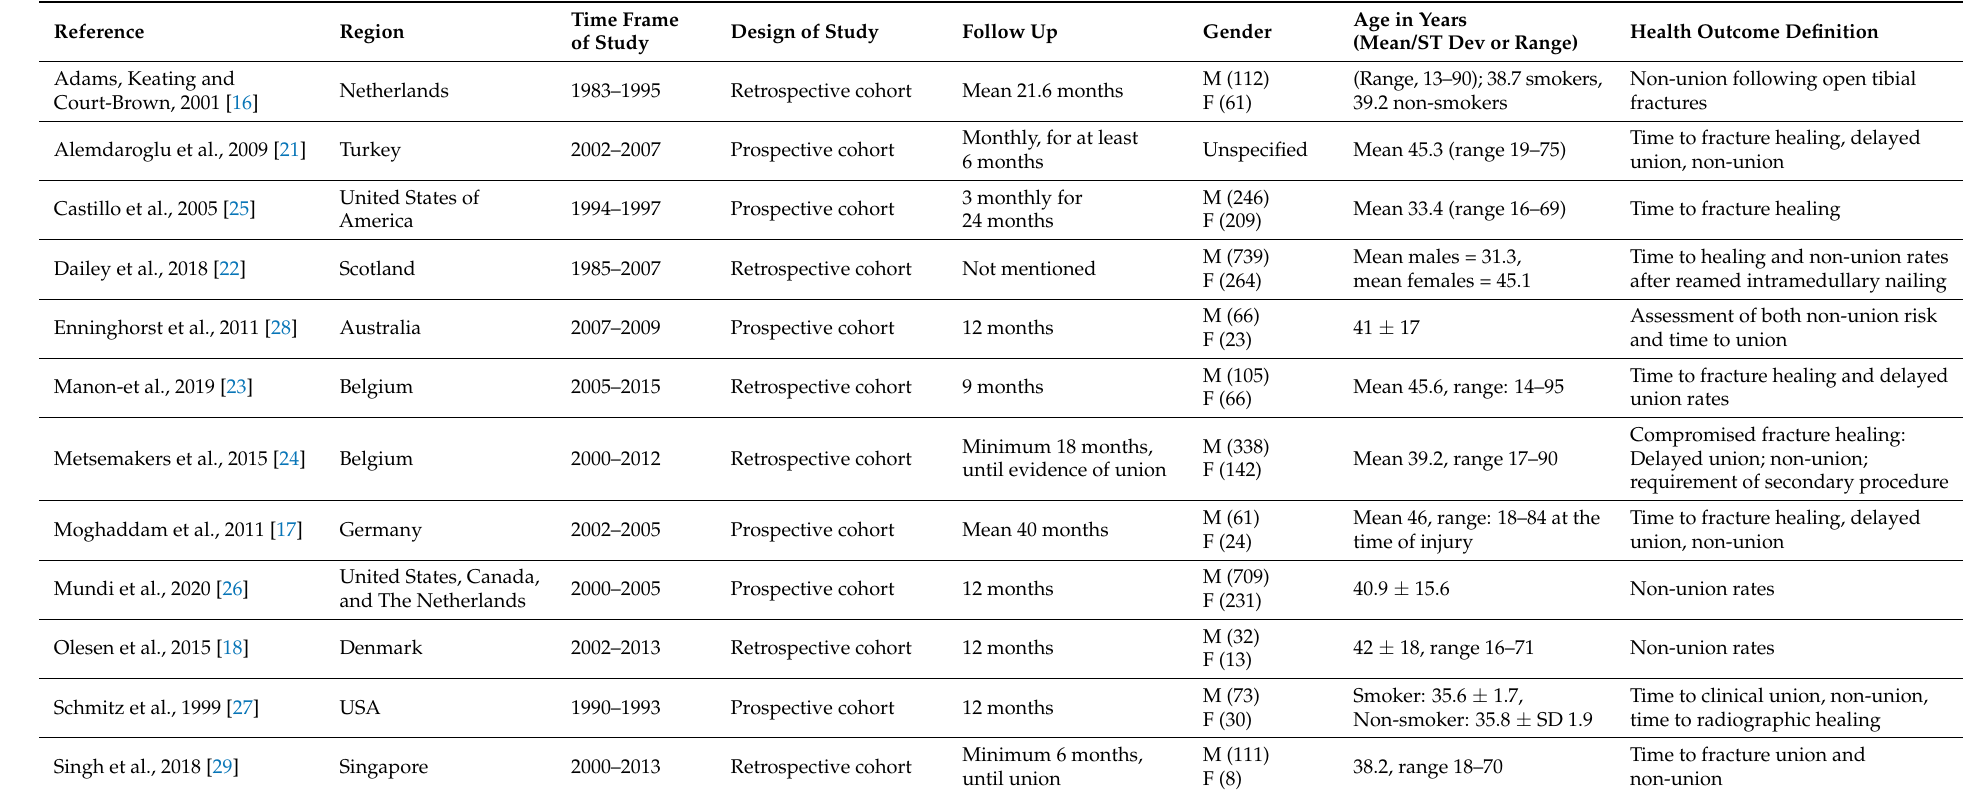
Table 1. Demographic characteristics and health outcome of study